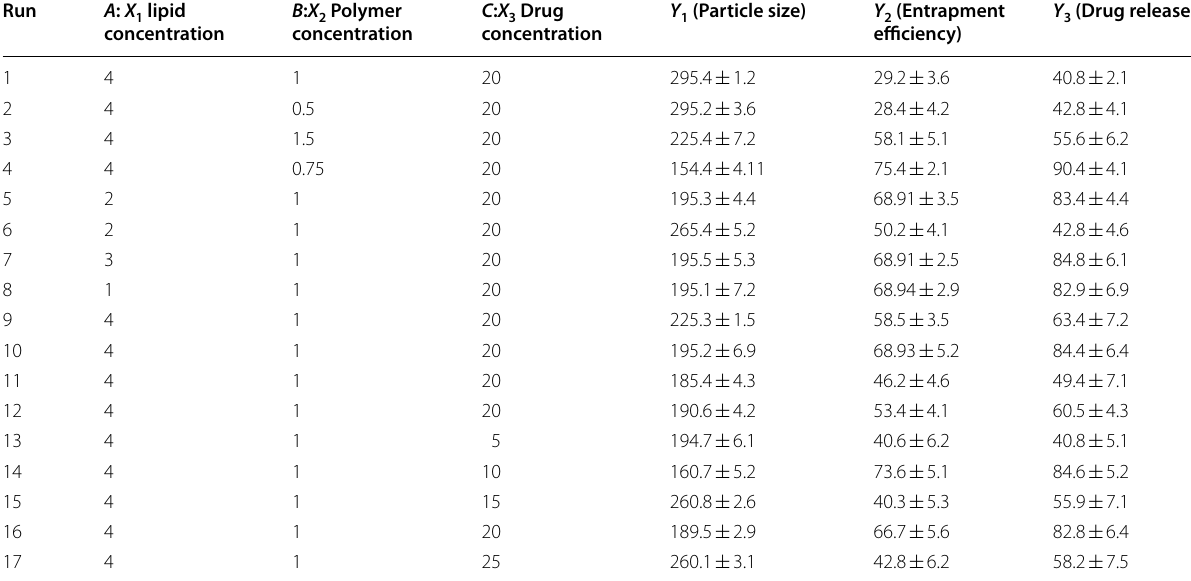
Table 2 The design and response of gallic acid-loaded nanoparticles according to the Box–Behnken experimental design Run